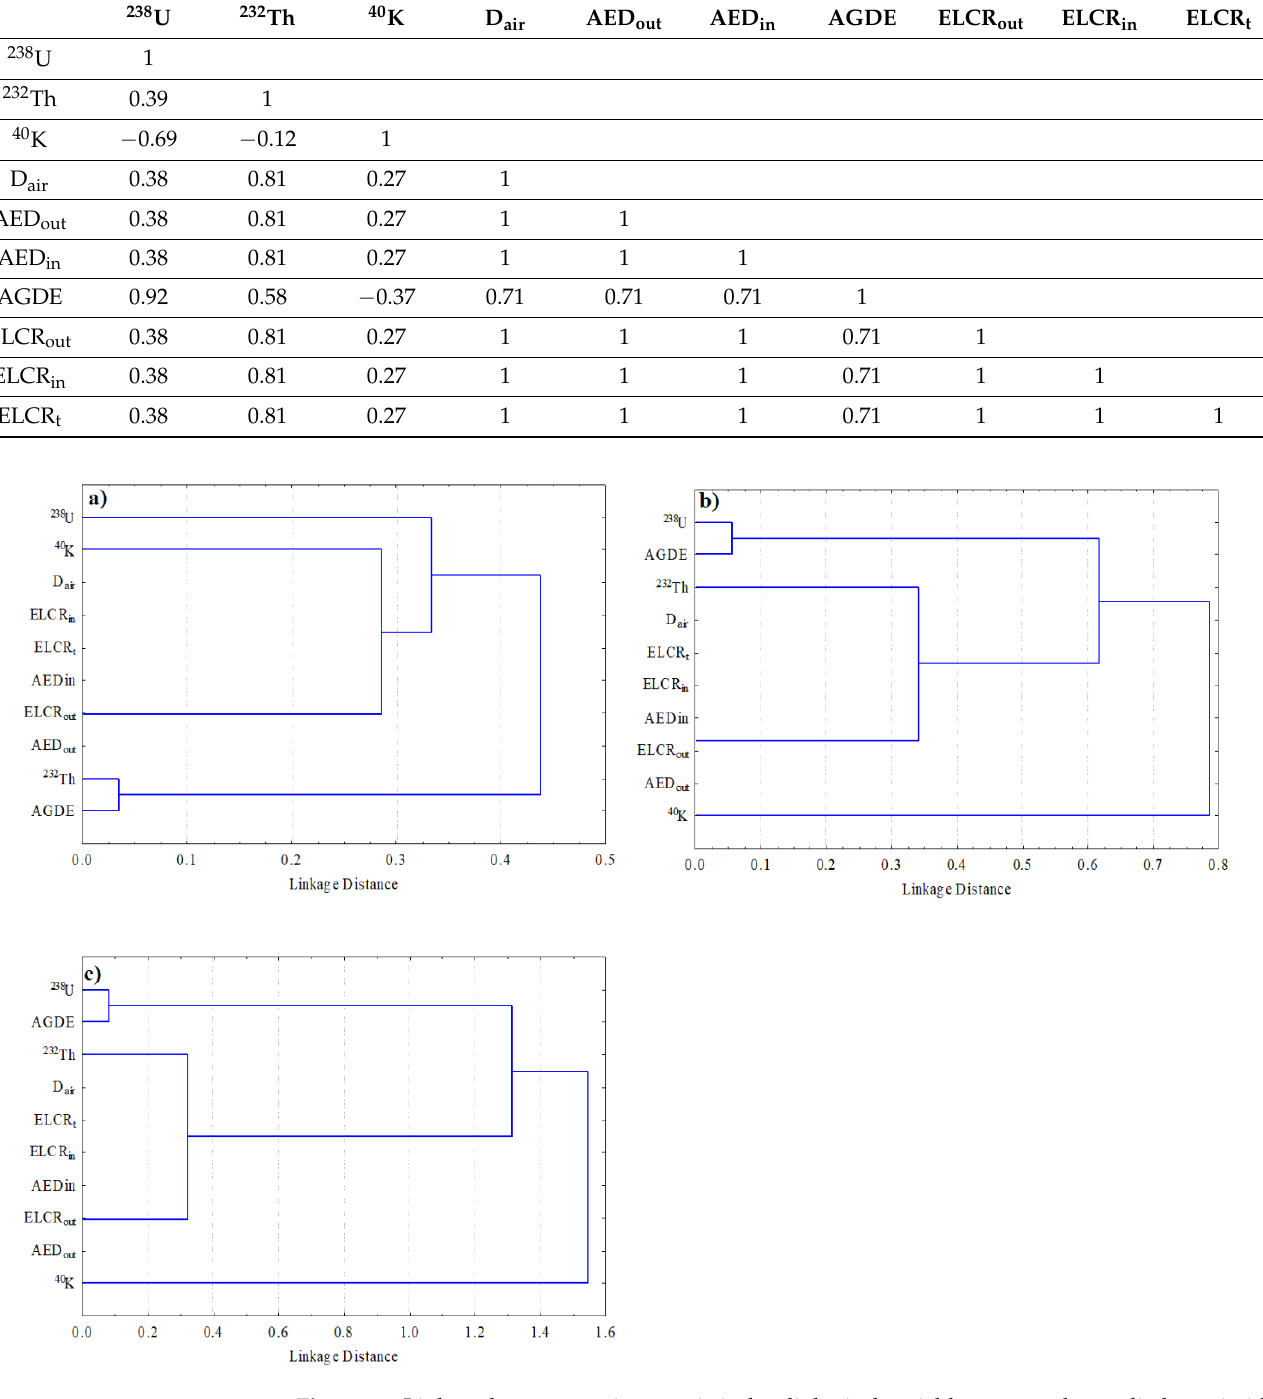
Figure 11. Linkage between various statistical radiological variables among the studied granitoids; ( a ) syenogranite, ( b ) alkali feldspar granite, ( c ) quartz syenite.